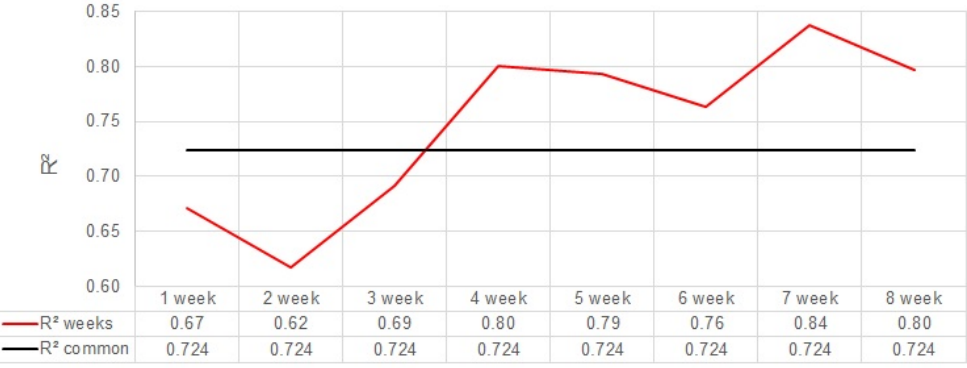
Figure 13. DE-OSELM modelling correlation results by the separate monitored weeks.